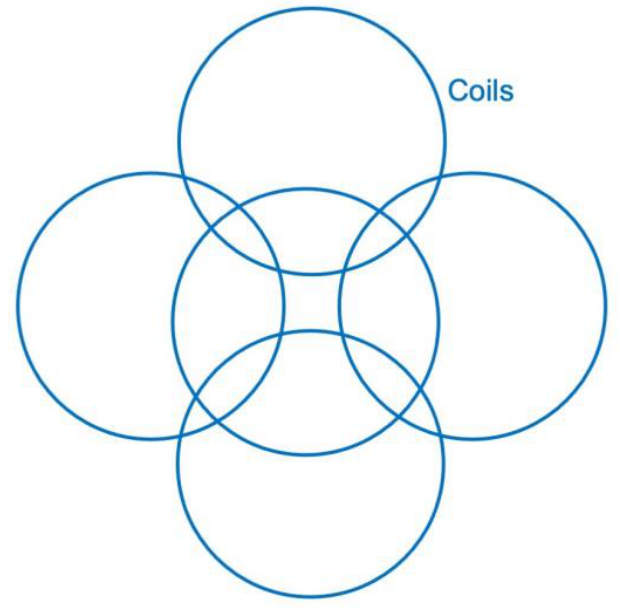
Figure 5. The arrangement of five coils, viewed from above, used in multi-excitation MAT-MI. By 2010—a mere five years after the introduction of magnetoacoustic tomography with magnetic induction—Bin He’s group was perfecting MAT-MI as a powerful tool for imaging biological tissue [20]. With Gang Hu, He was able to image tissue with a spatial resolution of better than 2 mm [21]. The resolution is ultimately set by the frequency response of the ultrasonic transducer. Their transducers responded to signals with a frequency of about 500 kHz. To further improve the resolution would require detecting higher frequencies, but such high-frequency waves suffer from severe attenuation. He’s team could image